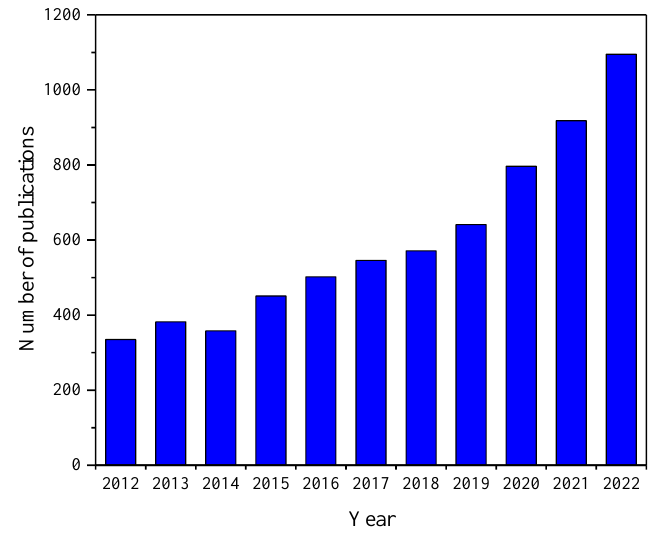
Figure 4. The number of research papers published per year focused on photoinitiating systems for photopolymerization according to Science Direct. Keyword: photoinitiator. Accessed on 13 Febru- ary 2023.